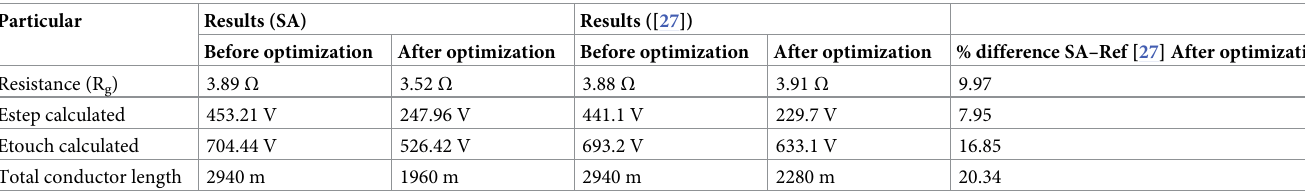
Table 16. Results for grounding system in horizontal two-layer soil ( ρ 1 < ρ 2 ). Particular